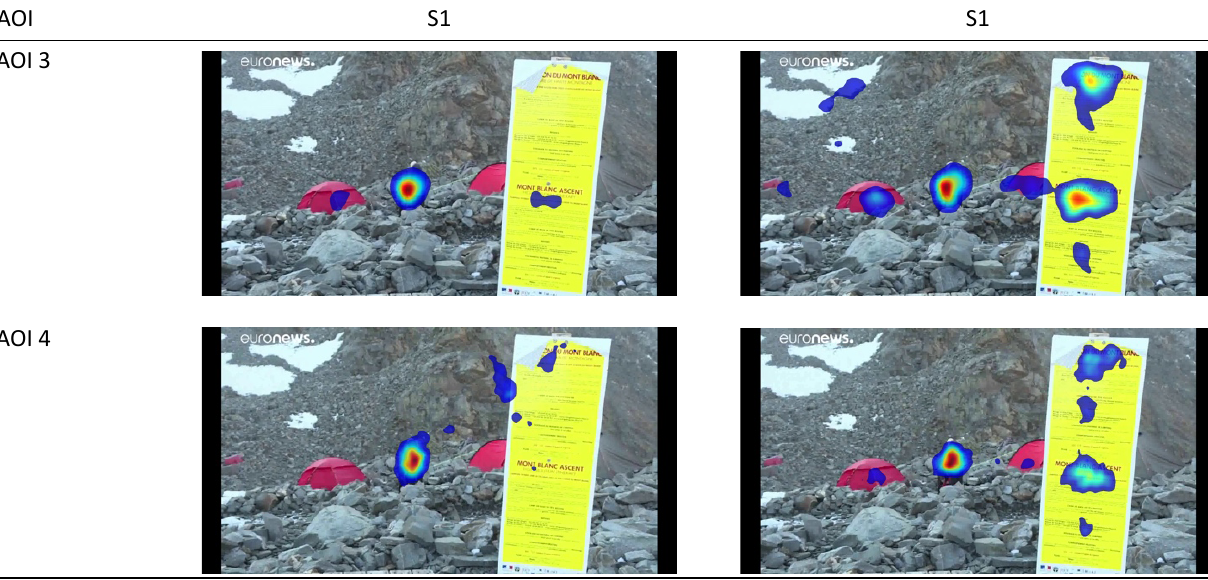
Table 6. Heat maps of the stimuli. AOI